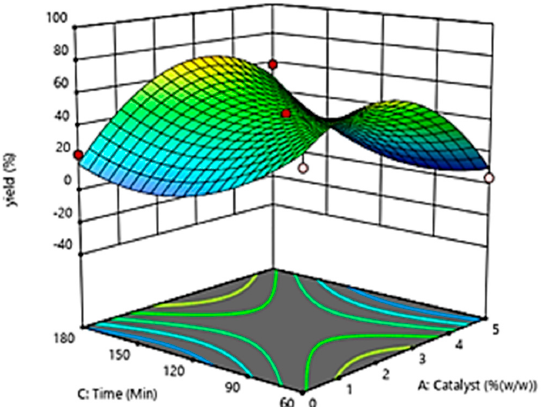
Figure 6. Biodiesel yield (%) vs. catalyst concentration (%) and reaction time (min).